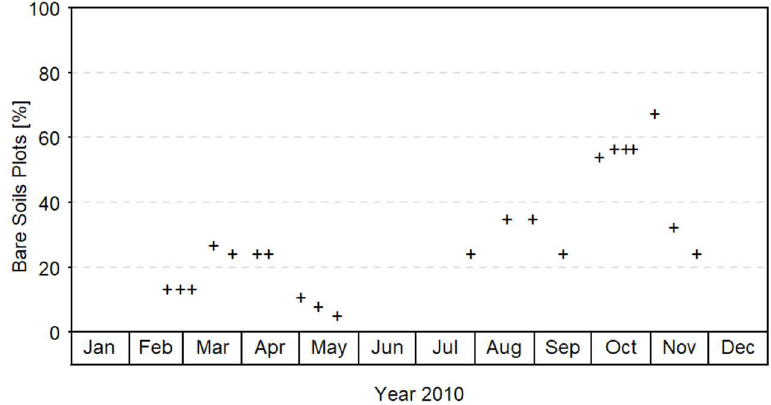
Figure 2. Relative number of bare soil plots (%) during the field campaign.